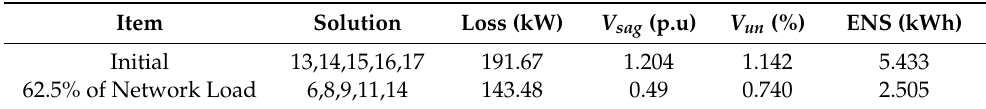
Table 8. The results of many objective reconfigurations of an unbalanced 13-bus network (62.5% of network load).